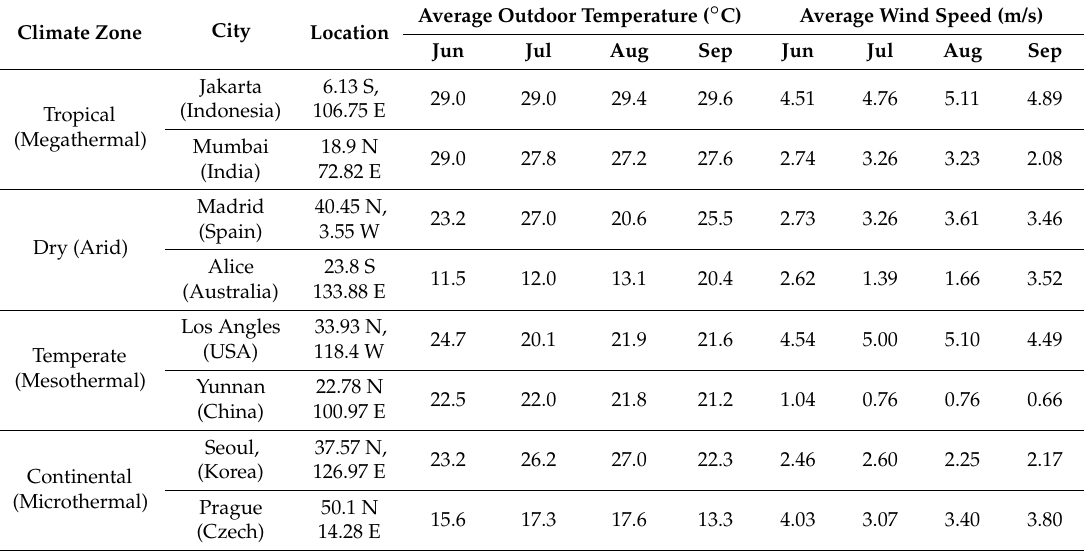
Table 1. Climate data for the eight cities analyzed (data source: Energyplus [13]).